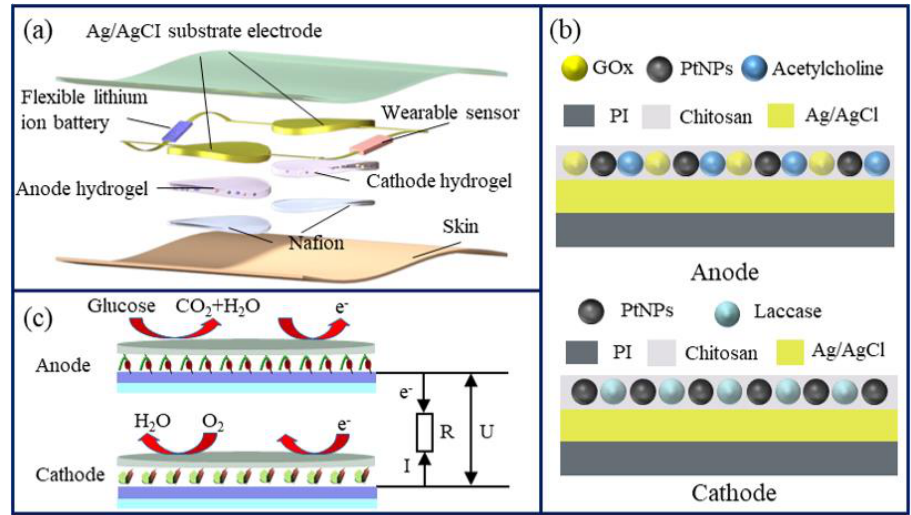
Figure 1. ( a ) Schematic of the electrically inspired flexible electrochemical film power. ( b ) Compositions of the anode (up) and cathode (down). ( c ) Mechanism of the flexible electrochemical energy source.